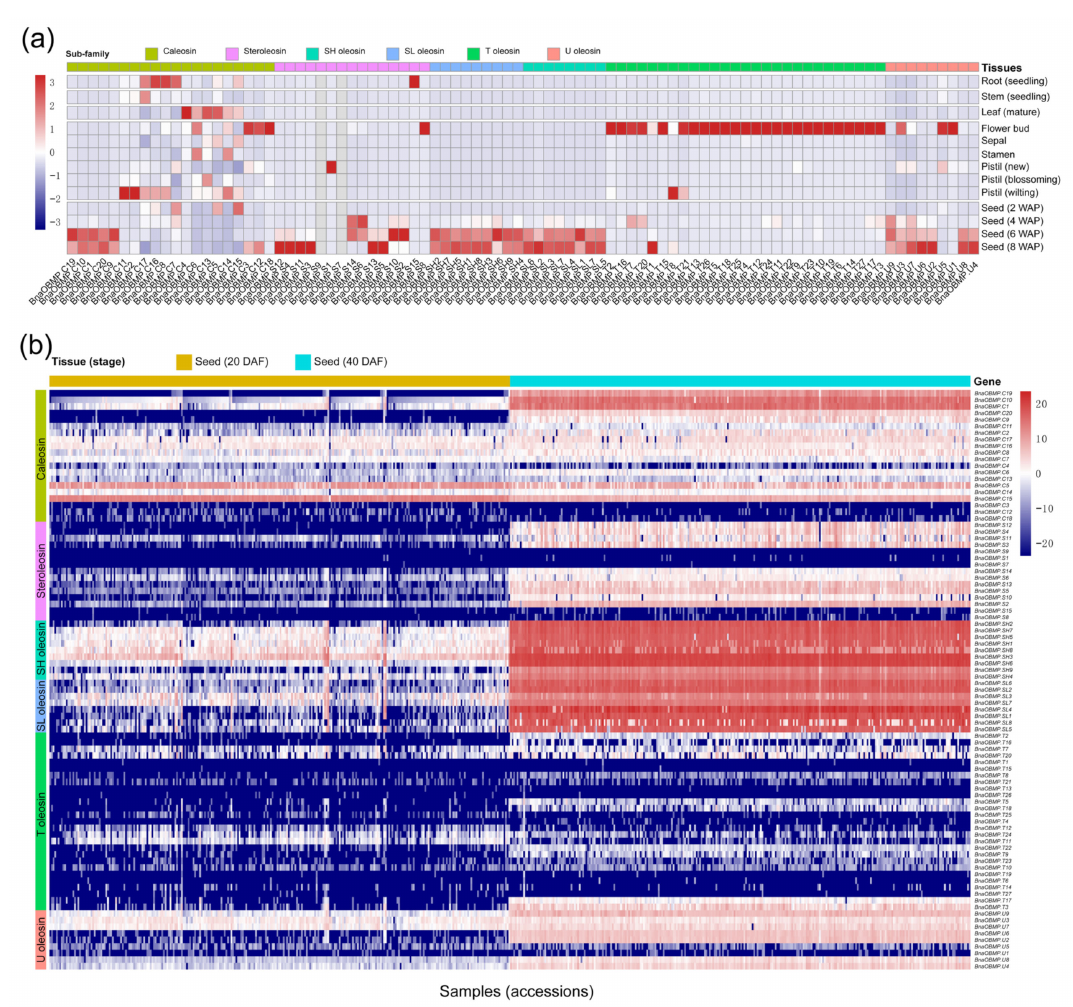
Figure 6. Expression analysis of the BnaOBMP genes in B. napus . ( a ) Expression patterns of the BnaOBMP genes in various tissues at different developmental stages. The color of each cell indicate the expression level of each BnaOBMP gene from low (blue) to high (red), expressed as log 10 FPKM. The OBMP gene subfamilies are marked by different colors that are shown in the color legend at the top. The tissues are listed at the right, with stages noted in the parentheses. ( b ) Expression patterns of the BnaOBMP genes in 20 DAF and 40 DAF seeds of 280 B. napus accessions. The 20 DAF (brown) and 40 DAF (cyan) seed samples of 280 B. napus accessions are displayed. Each OBMP gene subfamily is marked by the corresponding color on the